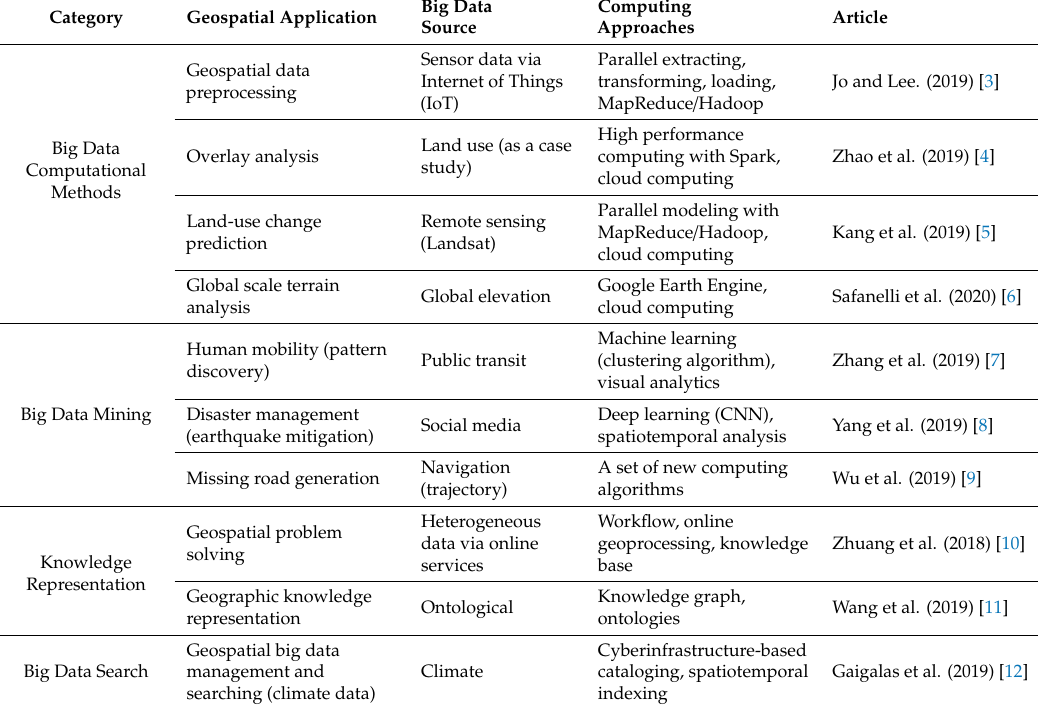
Table 1. Summary of the geospatial big data and computing approaches used in each article for various geospatial